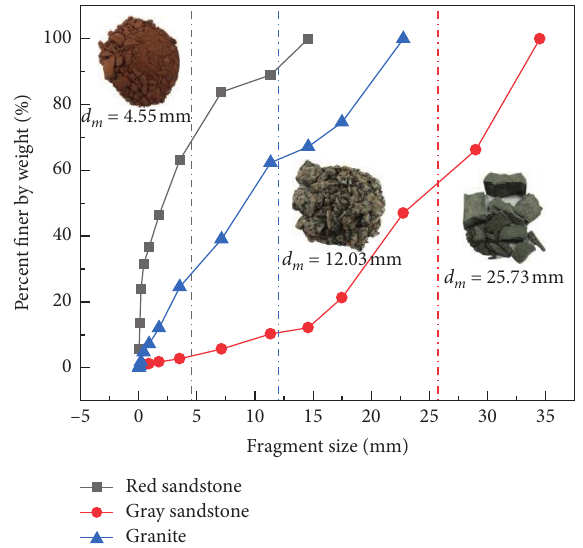
Figure 17: Comparison of fragment distributions at an impact speed of